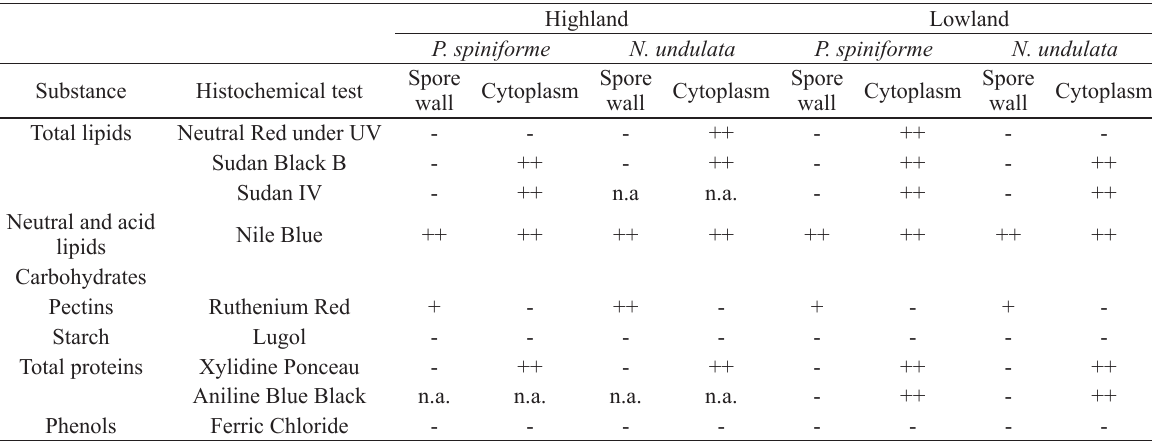
Results of histochemical tests applied on spores of two tropical mosses, N. undulata and P. spiniforme , in Brazilian Atlantic forest